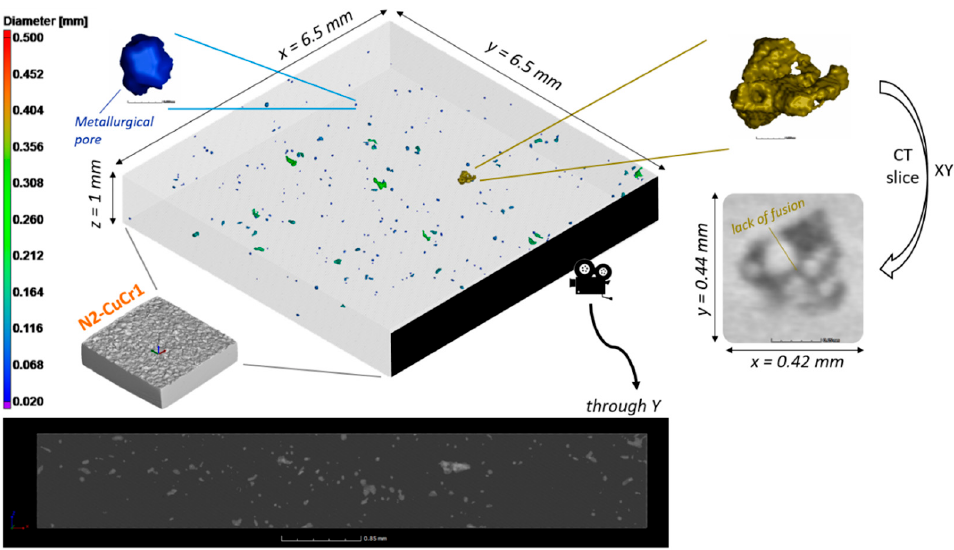
Figure 8. Overview of the porosity distribution for the N2-CuCr1 sample, comprising a color-coded 3D view of the porosities, zoomed representative metallurgical, and lack-of-fusion pores, as well as a 2D view through the Y direction of the sample.